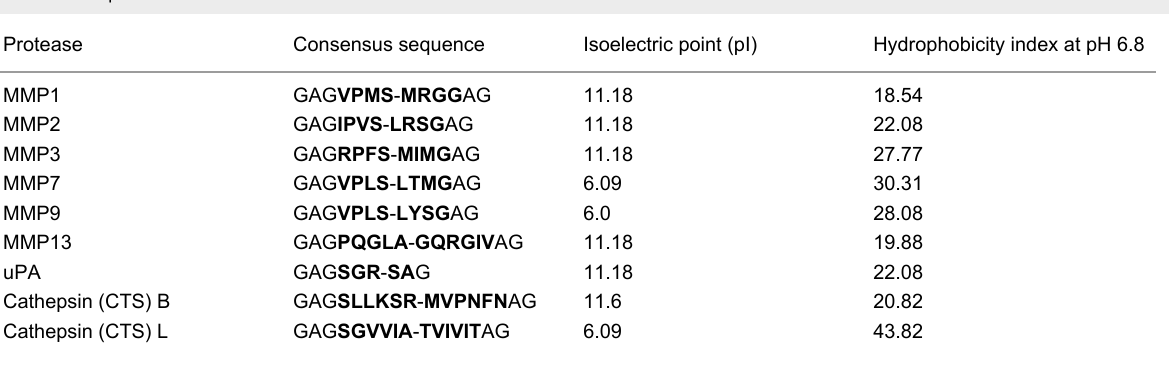
Table 1: Consensus sequences in single-letter code for 9 proteases (http://www.lifetein.com/peptide-analysis-tool.html). Essential amino acids of the consensus sequences are bold.